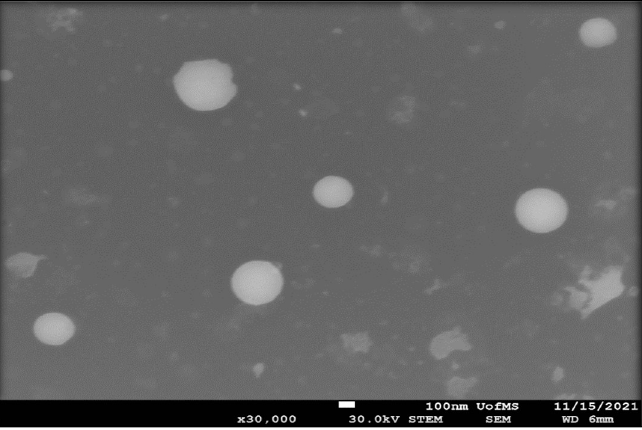
Figure 1. STEM micrograph of CBD-NEC formulation.